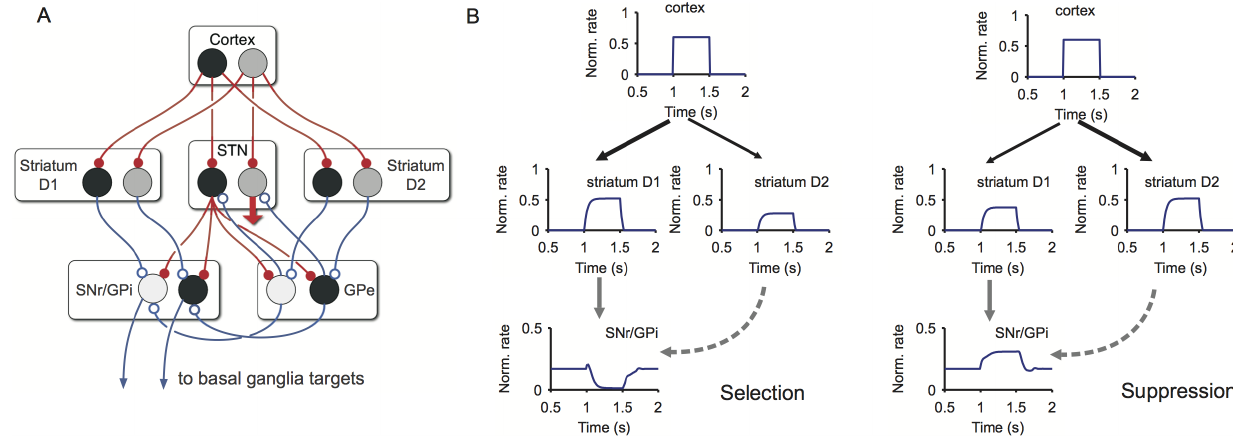
Figure 2. Model of basal ganglia dynamics. (A) Schematic of model architecture. It contains all major nuclei: STN, subthalamic nucleus; GPe, globus pallidus external segment; output nuclei (collectively)— SNr, substantia nigra pars compacta, and GPi, globus pallidus internal segment; striatum, with MSNs preferentially expressing D1 and D2 type dopamine receptors. Red and blue lines indicate excitatory and inhibitory connections, respectively. Circles indicate action-representing populations within each nucleus, each population modelled by its normalised mean firing rate, with relative rates represented by degree of shading (dark is highly active, pale grey is less so). In the interests of clarity, only two of the six channels are shown, and the diffuse projection from the channel on the right hand side in STN is shown as a single, wide red arrow (but mirrors its left-hand counterpart in terms of its individual connections to SNr/GPi and GPe). (B) Selection (left) and suppression (right) in the dynamical model. A phasic signal from cortex is input to a single channel in the model. Left: If the cortico-striatal weight is stronger to the channel’s D1 MSN population, then selection results: the corresponding SNr/GPi population’s activity is inhibited. Right: if the cortico-striatal weight is stronger to the channel’s D2 MSN population, then suppression results: via the effect of the enhanced D2 MSN input to the STN-GPe loop, the corresponding SNr/GPi population’s activity is excited. The model thus shows that a single cortical input drives coincident activity in D1 and D2 MSN populations, and that even within a single action-representing channel the two pathways are antagonistic.